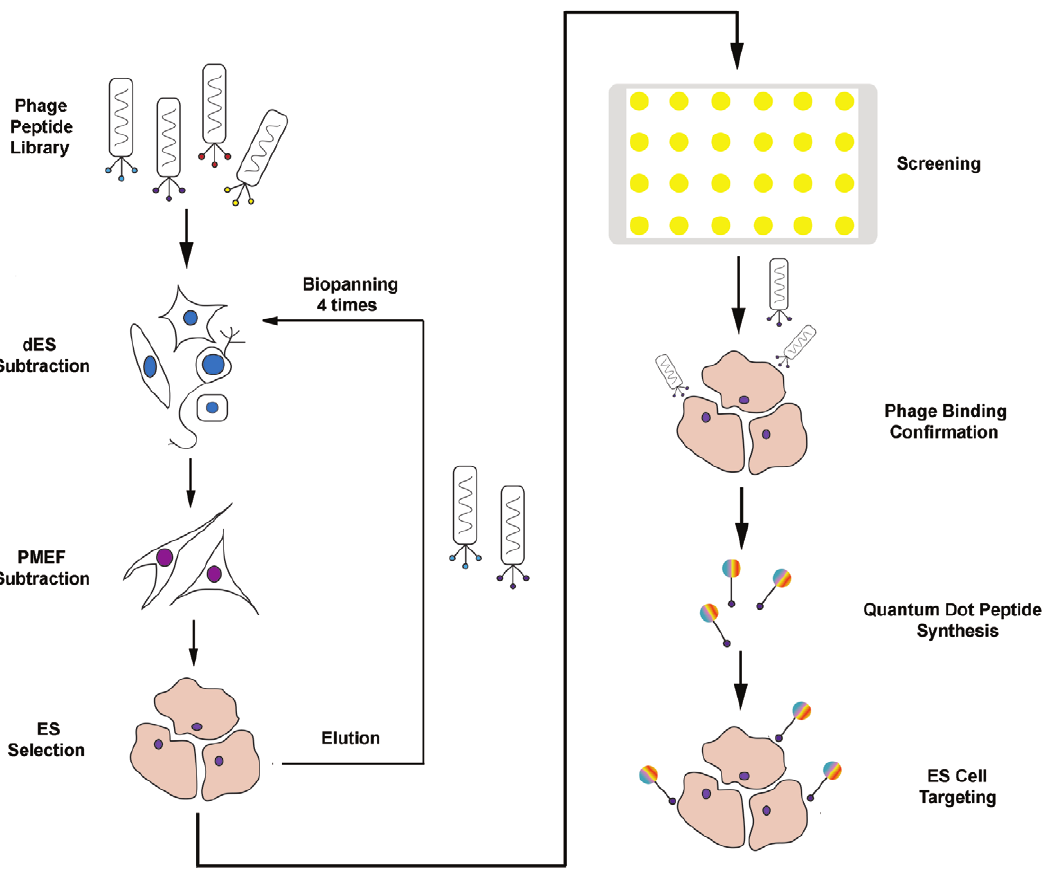
Figure 1. Scheme of experiment design. Initially, phages that specifically bind to ES cells were enriched in phage pool by four rounds of biopanning. Each round of biopanning included three subtraction steps with dES cells, three subtraction steps with PMEFs and a selection step with ES cells. After enrichment, monoclonal phages were purified and screened by enzyme linked immunosorbent assay (ELISA). Phages that showed higher binding ability and specificity were further confirmed with immunofluorescence microscopy. Then the selected peptide was chemically linked with quantum dots and the subsequent peptide-quantum dot conjugates were tested for ES cell targeting.